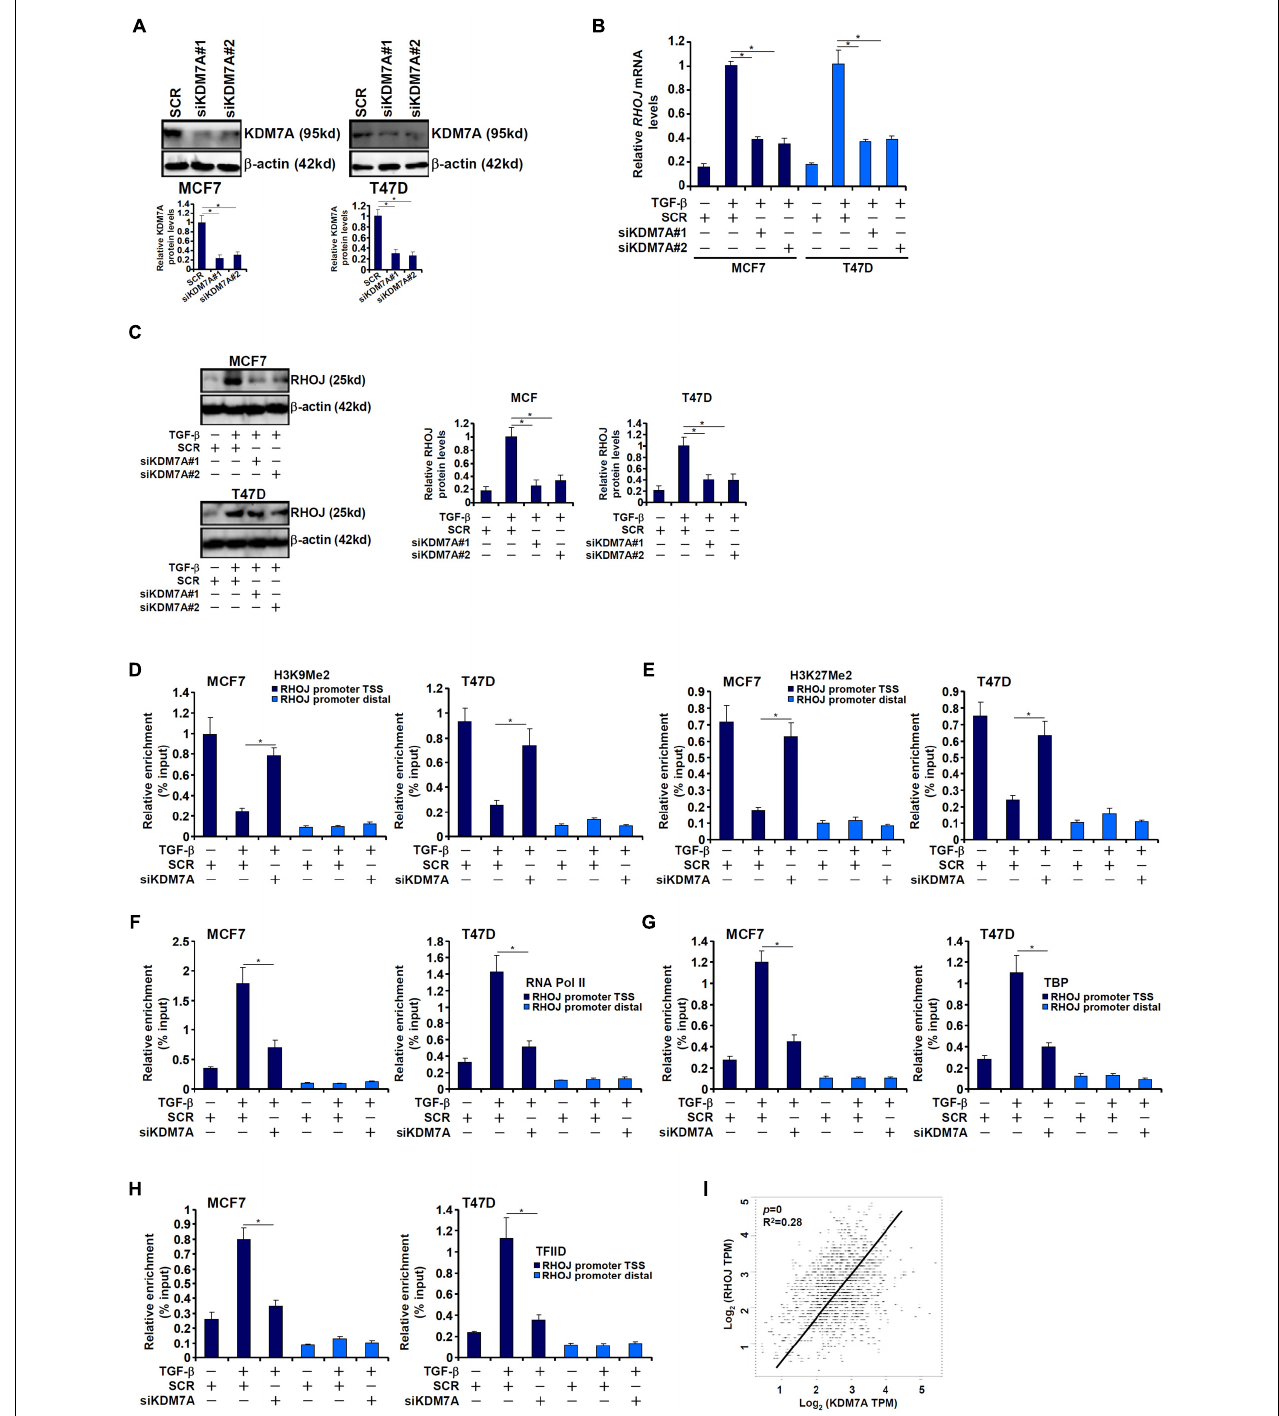
FIGURE 3 | JHDM1D/KDM7A mediates TGF- β -induced RHOJ transcription. (A–H) MCF7 (left panel) and T47D cells (left panel) were transfected with indicated siRNAs followed by treatment with TGF- β for 48 h. Knockdown efficiencies were validated by Western blotting (A) . RHOJ expression was examined by qPCR (B) and Western blotting (C) . ChIP assays were performed with anti-H3K9Me2 (D) , anti-H3K27Me2 (E) , anti-RNA polymerase II (F) , anti-TBP (G) , and anti-TFIID (H) . All experiments were performed in triplicate wells and repeated three times, and one representative experiment is shown. Data represent mean ± SD. * p < 0.05, two-tailed t -test. KDM7A mediated RHOJ trans-activation by removing H3K9/H3K27 methylation to facilitate the recruitment of RNA polymerase II, TBP, and TFIID to the RHOJ promoter. (I) Expression data were extracted from the public database to draw the scatter plot. Pearson correlation coefficient was calculated. Positive correlation between KDM7A expression and RHOJ expression was identified in human breast cancer tissues.